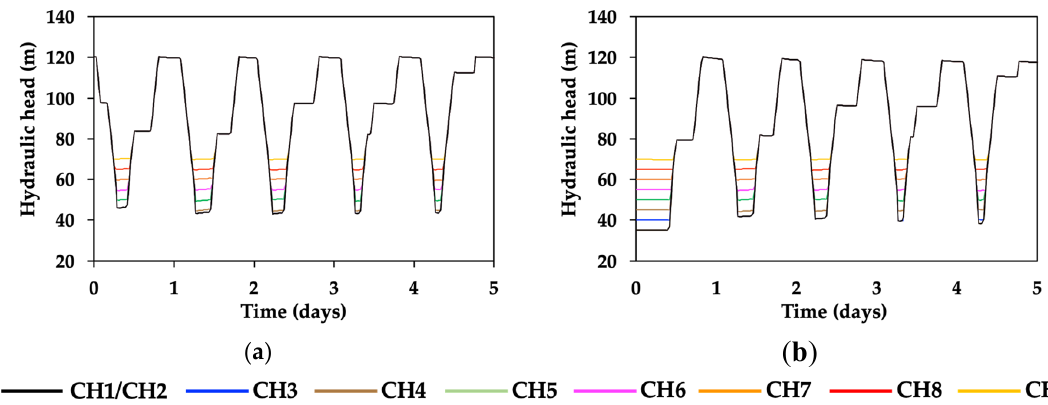
Figure 9. Hydraulic head evolution inside the chambers for scenarios ( a ) F-CI and ( b ) E-CI.